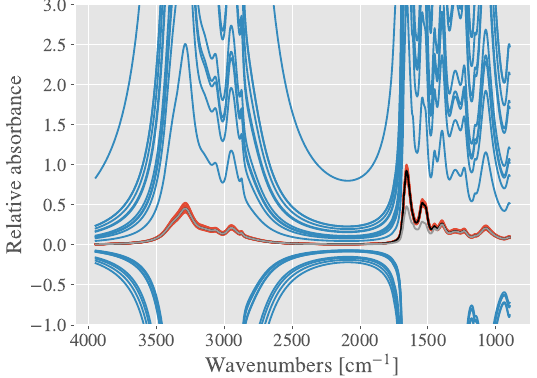
Figure 4. Major pitfall when adding constituent spectra to EMSC models; if the constituent spectra are not orthogonal to the rest of the model spectra, the least squares regression becomes ill-posed, and the parameter estimation becomes highly unstable. The corrected spectra from the blue group demonstrate that the scaling parameter is wrongly estimated. The reference spectrum in the EMSC model (mean of red group) is shown in black, while the analyte constituent spectrum is shown in gray (mean of blue